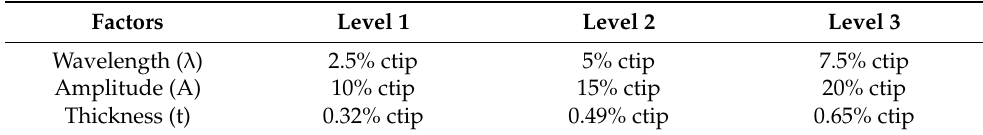
Table 1. Taguchi design parameters and factor